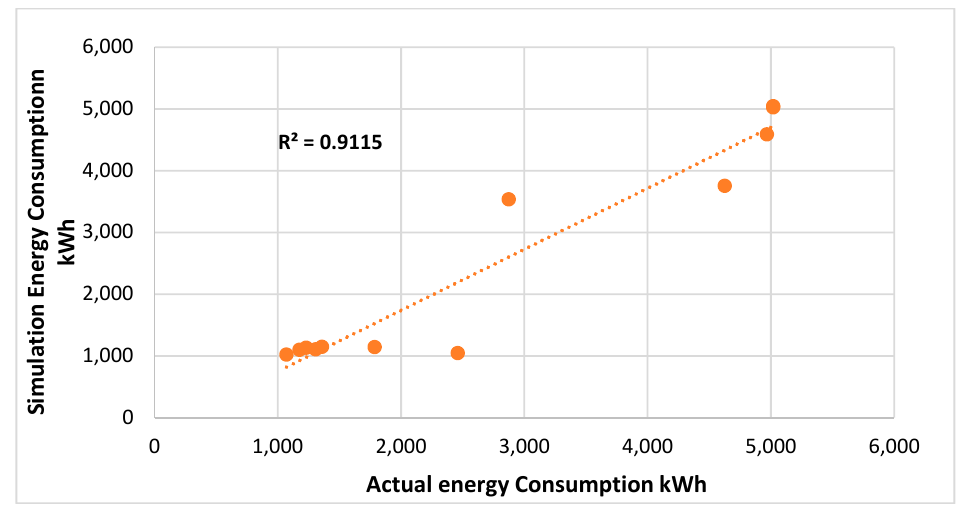
Figure 10. The correlation plot of the two variables: the energy consumption obtained using the simulation with the AC working on the continuous mode at a thermostat setting of 20 °C and by using the direct measurement obtained from the monthly bills.